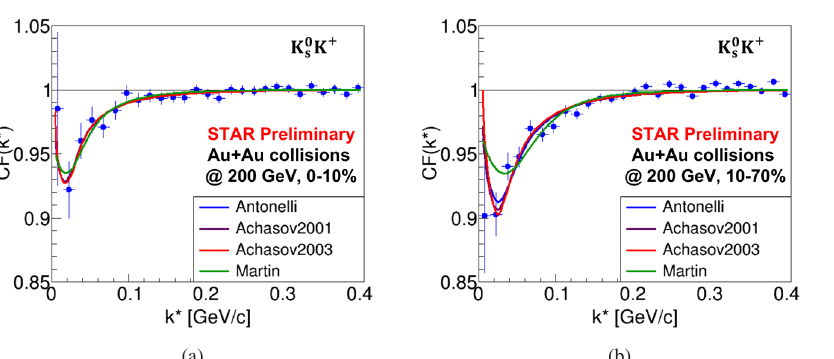
K + correlation functions for √ s NN = 200 GeV for central (a) and noncentral (b) collisions Figure 2. K 0 S with Lednicky-Lyuboshitz parametrizations. Only statistical